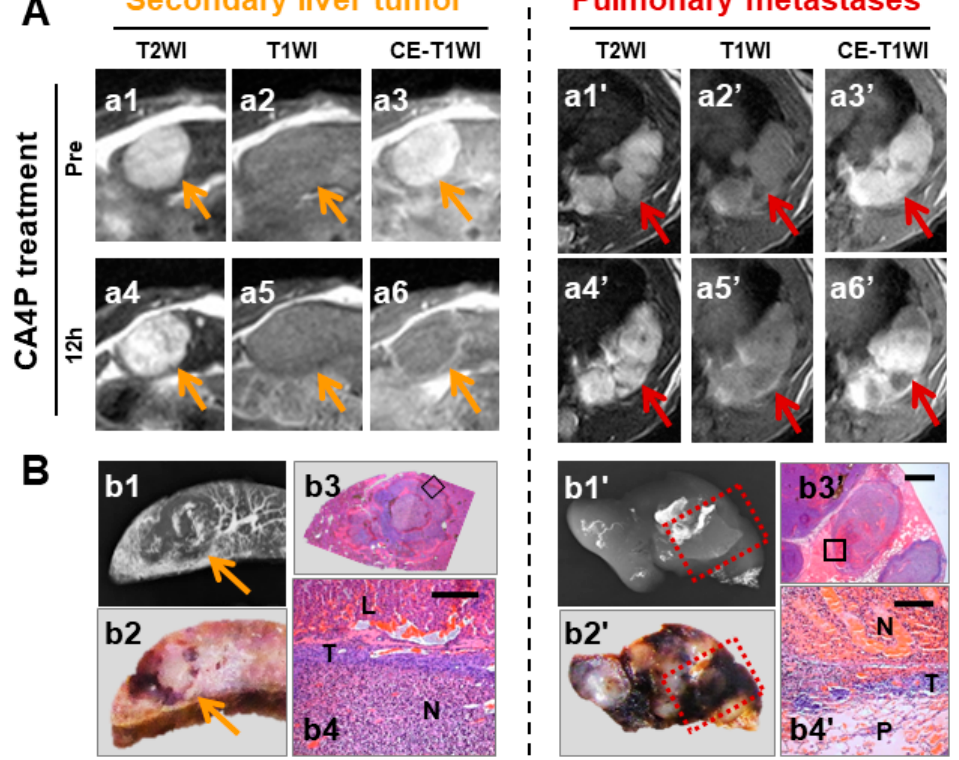
Figure 6. Intraindividual comparison indicating superior response in secondary liver tumor but inferior efficacy in pulmonary metastases with VDA. ( A ): In vivo MRI at three weeks after intrahepatic R1 implantation: initially, both liver R1 (orange arrows) and pulmonary metastases (red arrows) from the same tumor origin appeared hyperintense on T2WI (a1, a1 (cid:48) ), iso- to slightly hyper-intense on T1WI (a2, a2 (cid:48) ) compared with live parenchyma, and were enhanced on Gd-DOTA CE-T1WI (a3, a3 (cid:48) ). Twelve hours after CA4P treatment, nearly complete necrosis occurred in hepatic R1 tumors, as reflected by extremely hyperintense on T2WIs (a4), isointense on T1WIs (a5) and an unenhanced core with a hyperenhanced rim on CE-T1WIs (a6); by contrast, regional necrosis in pulmonary metastasis was noted by hyperintensity on T2WI (a4 (cid:48) ) and T1WI (a5 (cid:48) ), and partial enhancement on CE-T1WI (a6 (cid:48) ). ( B ): Corresponding microangiograms (b1, b1 (cid:48) ), photomacrographs (b2, b2 (cid:48) ) and photomicrographs (H&E staining; b3, b3 (cid:48) , original magnification × 12.5, scale bar = 800 µ m; b4, b4 (cid:48) , original magnification × 100, scale bar = 100 µ m) of liver and pulmonary R1